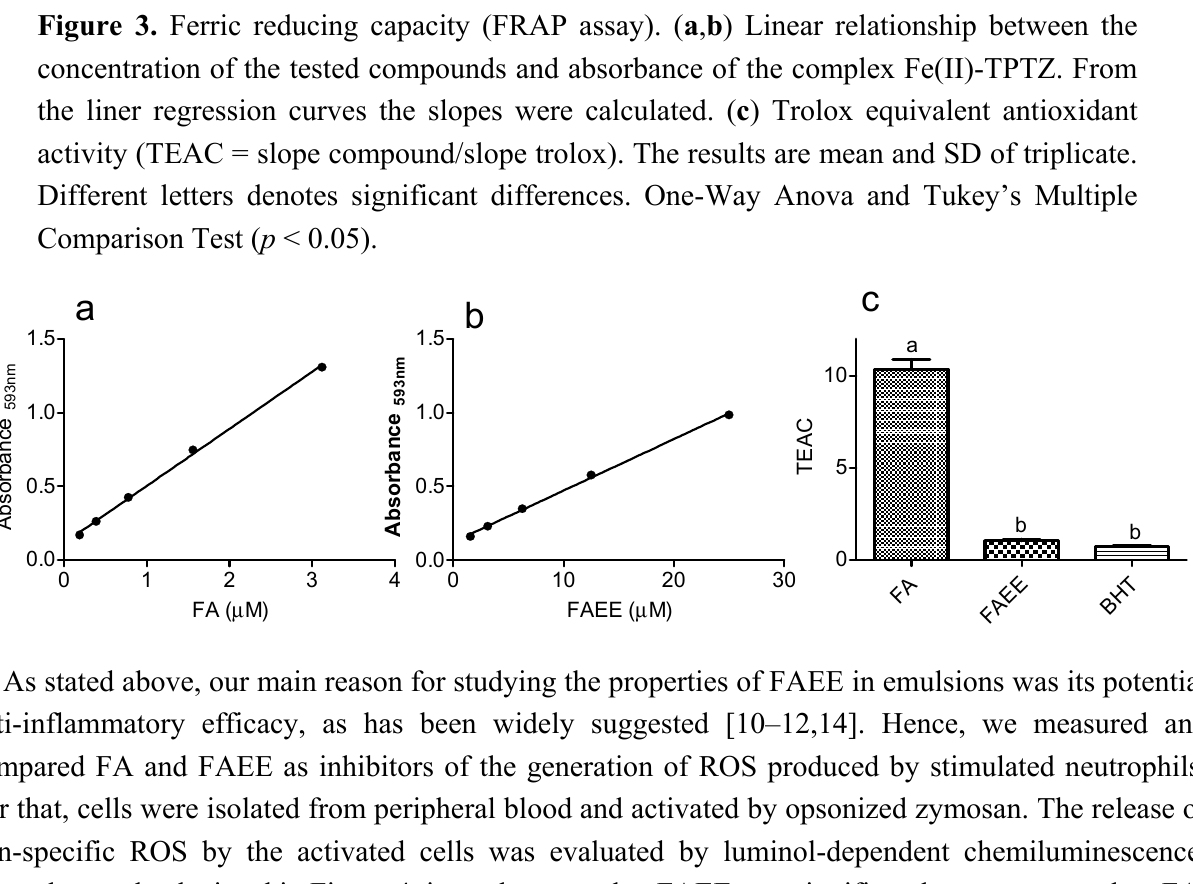
Figure 4. Inhibitory effect on ROS produced by stimulated neutrophils. The cells were stimulated by opsonized zymosan and the production of ROS evaluated by luminol- dependent chemiluminescence. The results are mean and SD of duplicates of three different experiments. Different letters denotes significant differences. One-Way Anova and Tukey’s Multiple Comparison Test ( p < 0.05). The different concentrations of the tested compounds were treated separately in the statistical analysis (a and a , b and c for 100 2 2 2